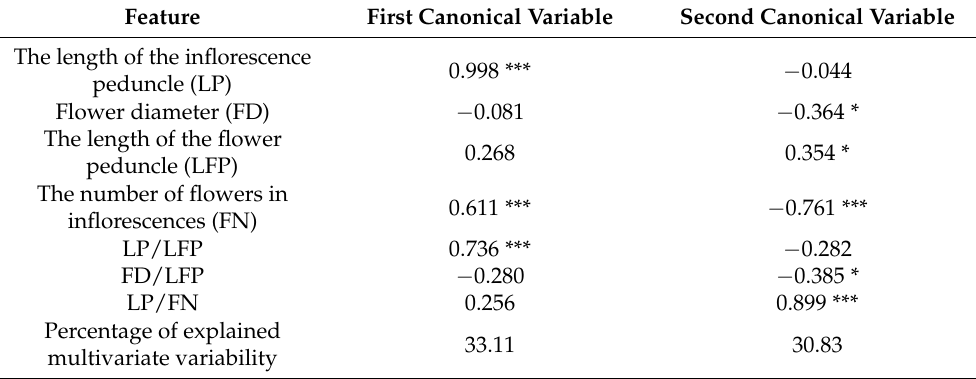
Figure 7. Distribution of 39 trees in the space of the first canonical variable (V 1 ) and the second canonical variable (V 2 ). Table 4. Correlation coefficients between the first two canonical variates and studied features for trees.